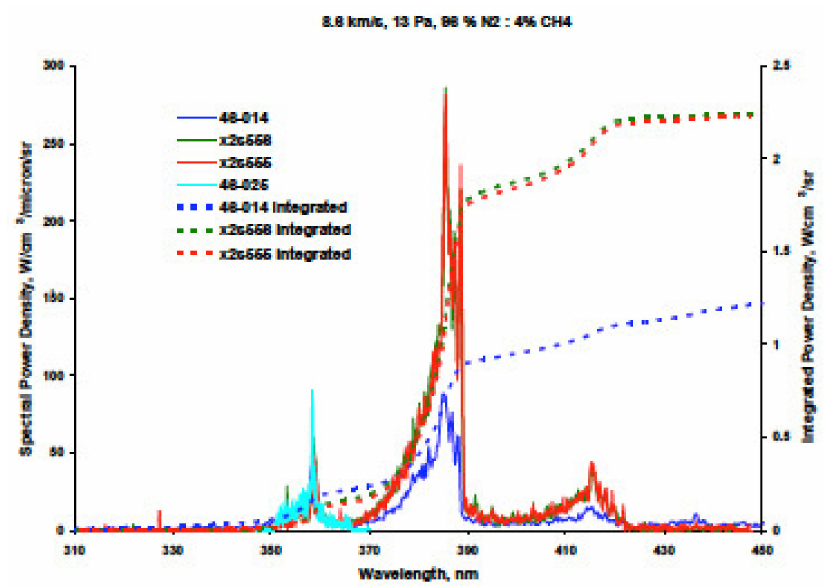
Figure 37. Wavelength comparison between EAST and X2 for Mars conditions (datasets from X2 are started by x2 in the legend) (from [34]).